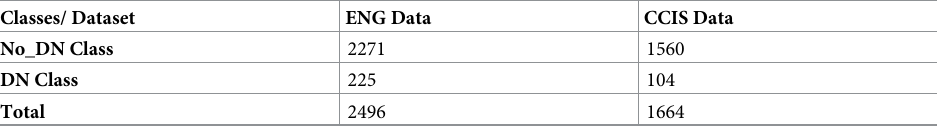
Table 7. The class size of ENG and CCIS datasets before applying the sampling approaches.